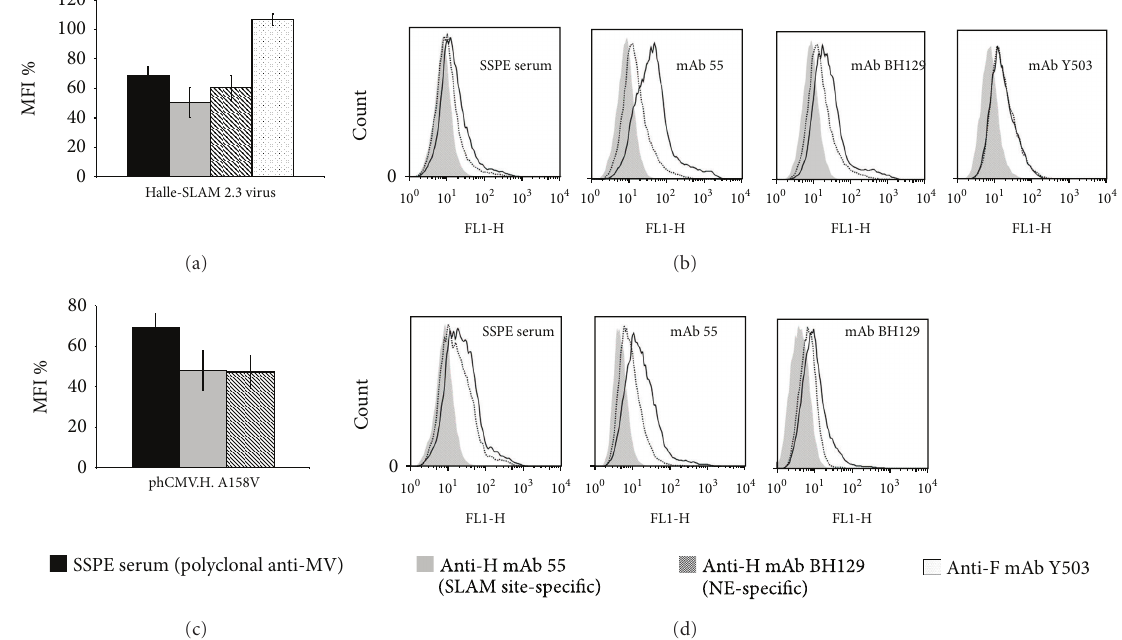
Figure 4: Flow cytometry analysis of escape mutant Halle-SLAM 2.3 (H: A158V; F: no change; M: M239I). Vero-SLAM cells infected with the escape mutant virus or transfected with phCMV expressing the mutated H, in the presence of antifusion tripeptide FIP when necessary, were analysed 1 day after infection or after transfection using the four antibodies indicated. Each overlay histogram represents one experiment; the MFI histogram data represent the mean percentages ± standard deviations for three experiments. These values were obtained by using nonmutated Halle virus or expressed nonmutated Halle-H protein as controls. (a) and (b)) Escape mutant Halle-SLAM 2.3-infected cells; ((c) and (d)) cells transfected with